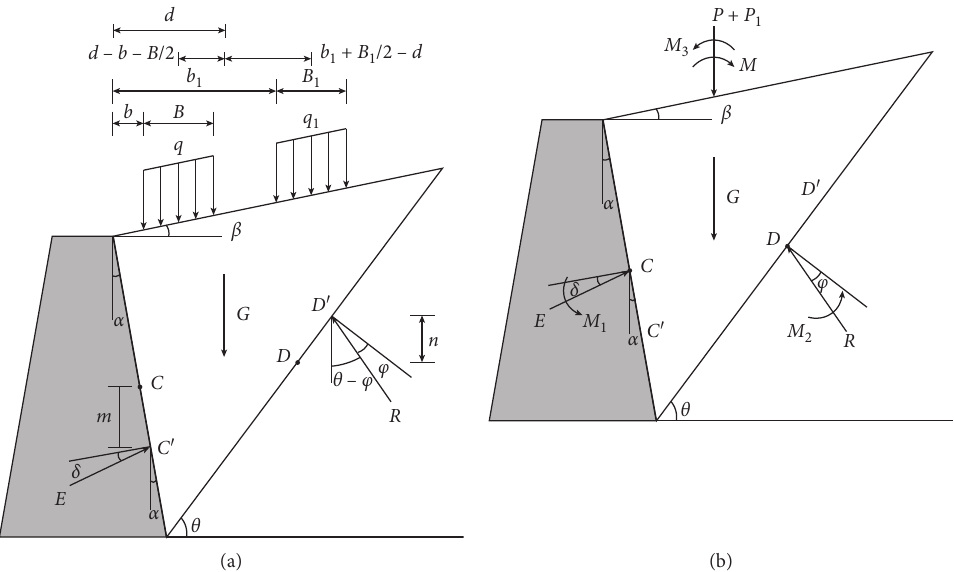
Figure 4: Double strip surcharge condition for the retaining wall. (a) Physical model. (b) Equivalent moment